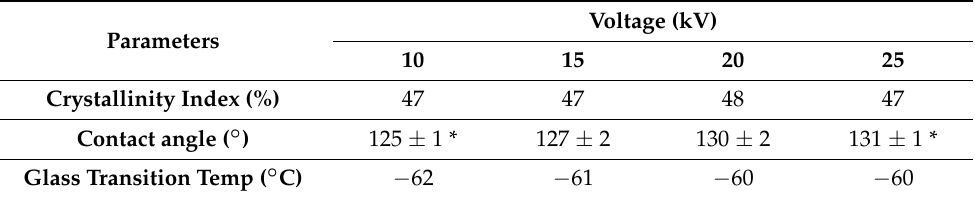
Table 1. Crystallinity index, water contact angle and glass transition temperature (see Supplementary Materials) of electrospun nanofibers prepared at different